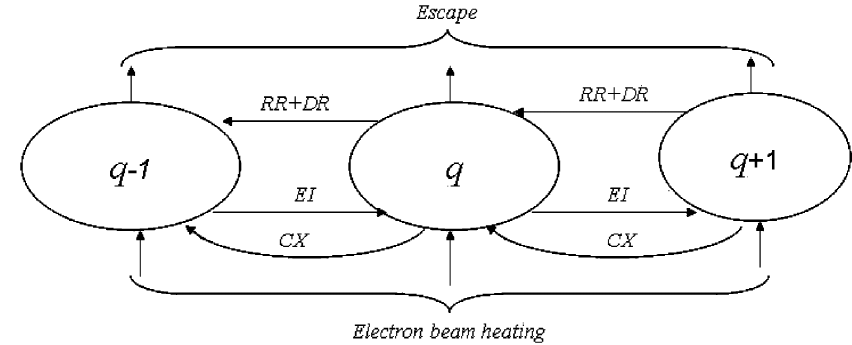
NUMERICAL SIMULATION OF THE . .